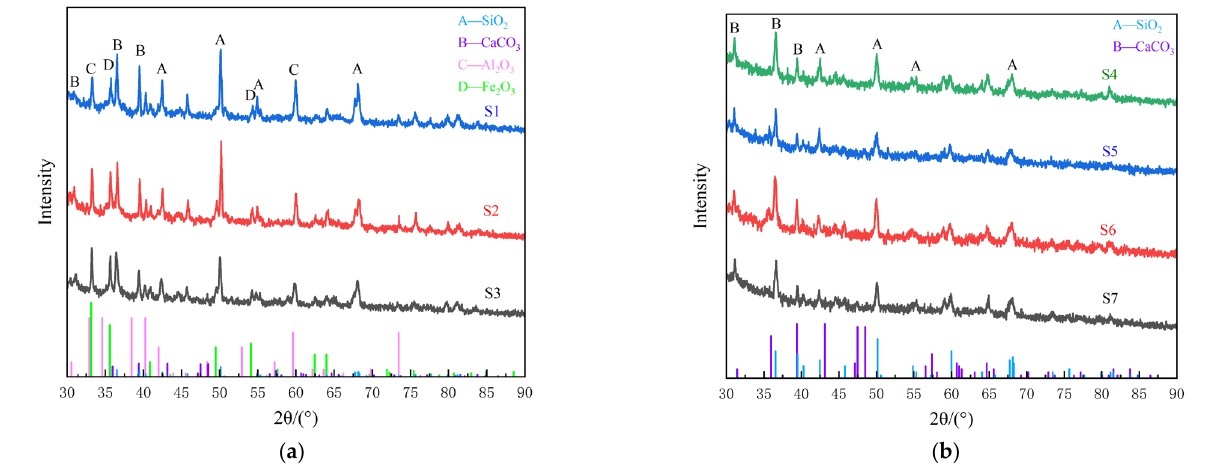
Figure 6. Measured XRD patterns of the clinker bricks (traces labelled S1–S7): ( a ) S1–S3; ( b ) S4–S7. The standard XRD patterns for the identified compounds are also shown at the bottom of the plots. (3)